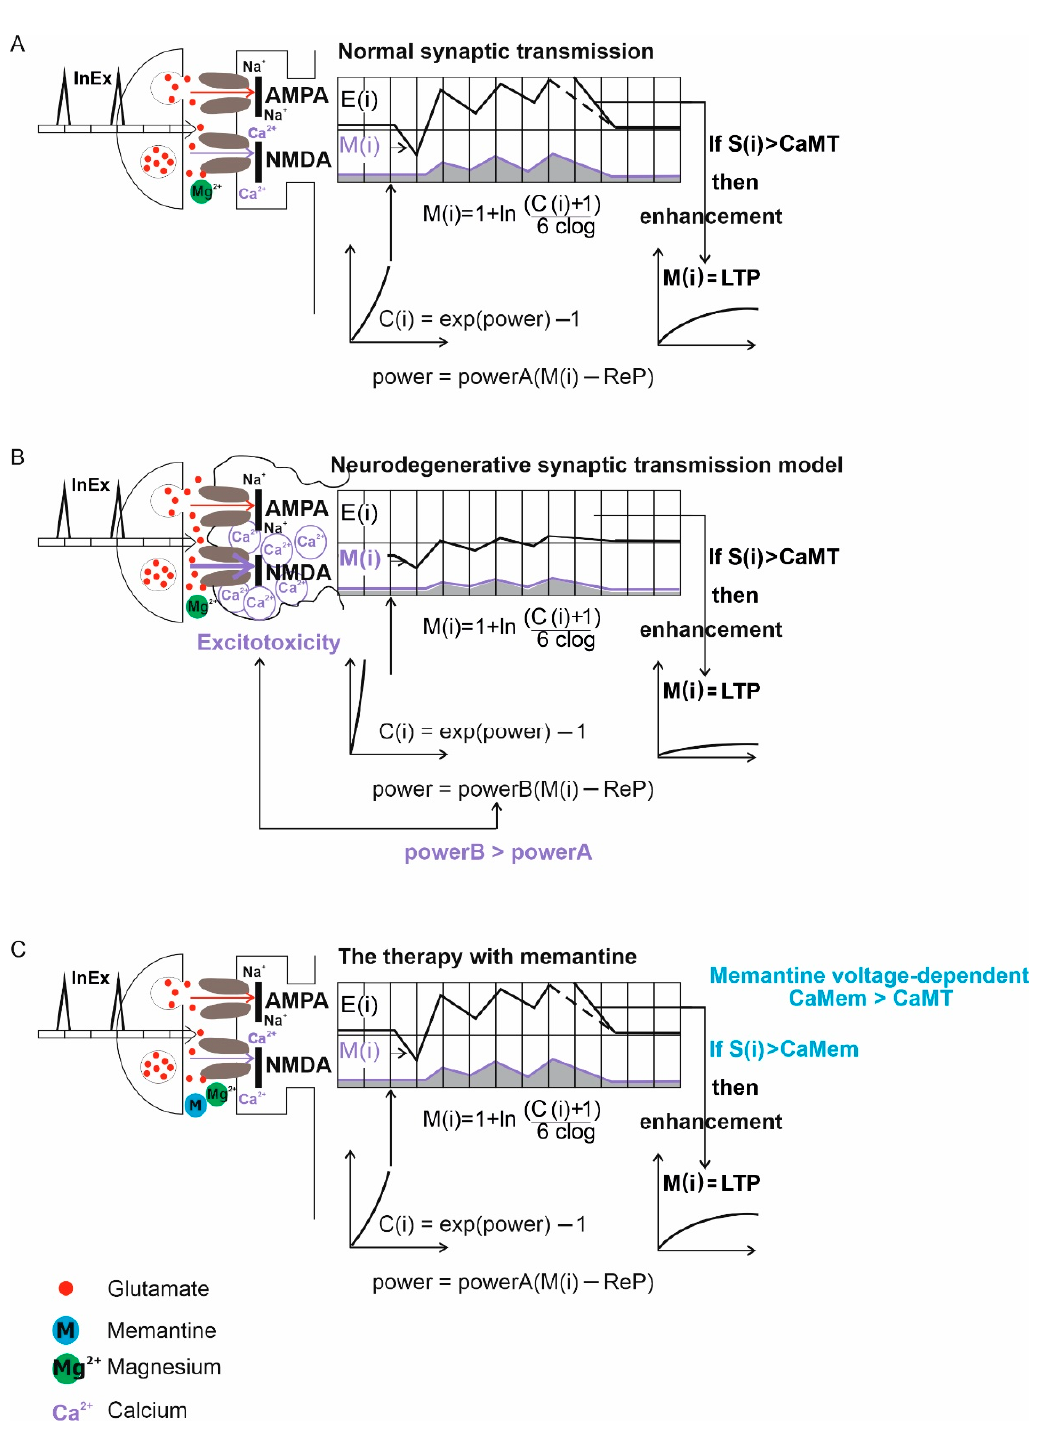
Figure 1. NMDA receptor activity in physiological (normal) synaptic transmission and pathological (neurodegenerative) dementia synaptic transmission situations, as well as treatment with memantine. ( A ) Normal synaptic transmission. The unblocking of the channel and the influx of Ca 2+ ions into